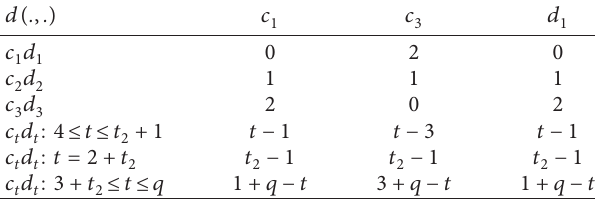
Table 5: Codes of spokes of GP ( q, 1 ) when q is even. d ( ., . )